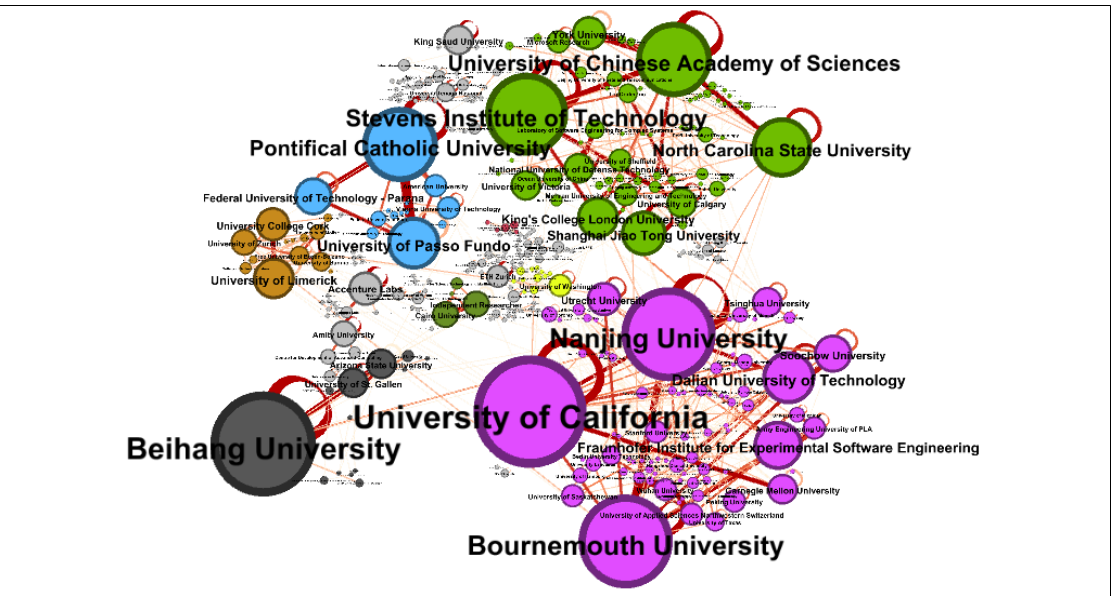
Figure 8. Clustering of institutions involved in CSE co-authorships.